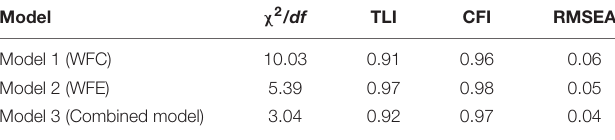
TABLE 2 | Fit indices of the model of WFC, WFE, and comprehensive ( N =